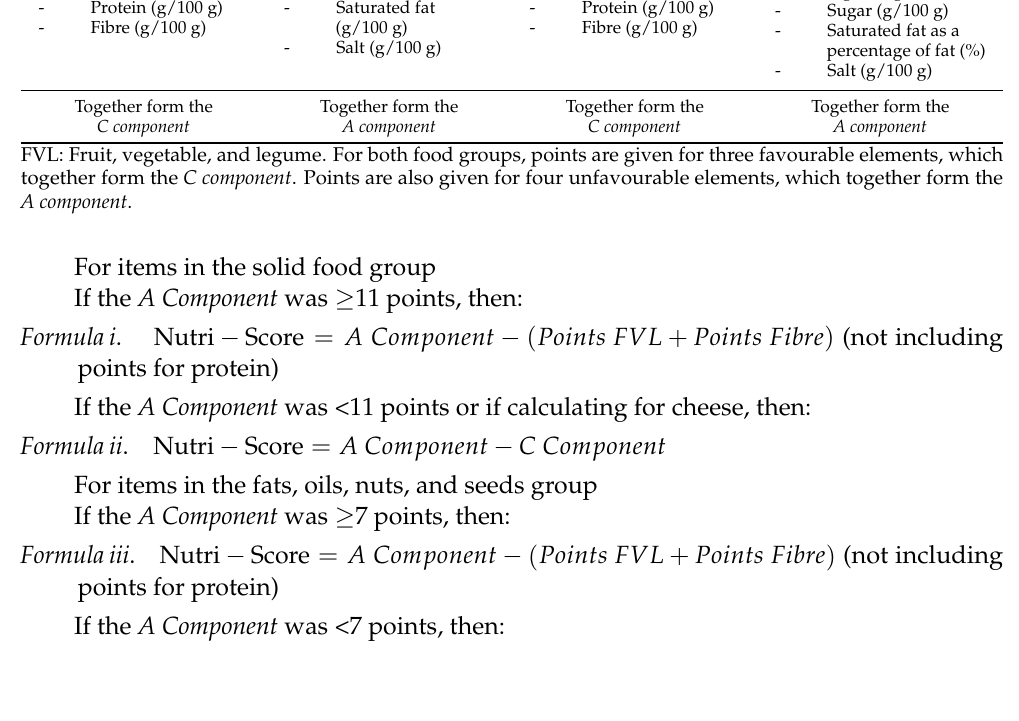
Table 1. Distinction between “favourable” and “unfavourable” elements within both food groups (solid foods and fats, oils, nuts, and seeds), as specified by the Nutri-Score 2022 algorithm [24]. For Solid Foods For Fats, Oils, Nuts, and Seeds Favourable Unfavourable Favourable Unfavourable Elements Elements Elements Elements